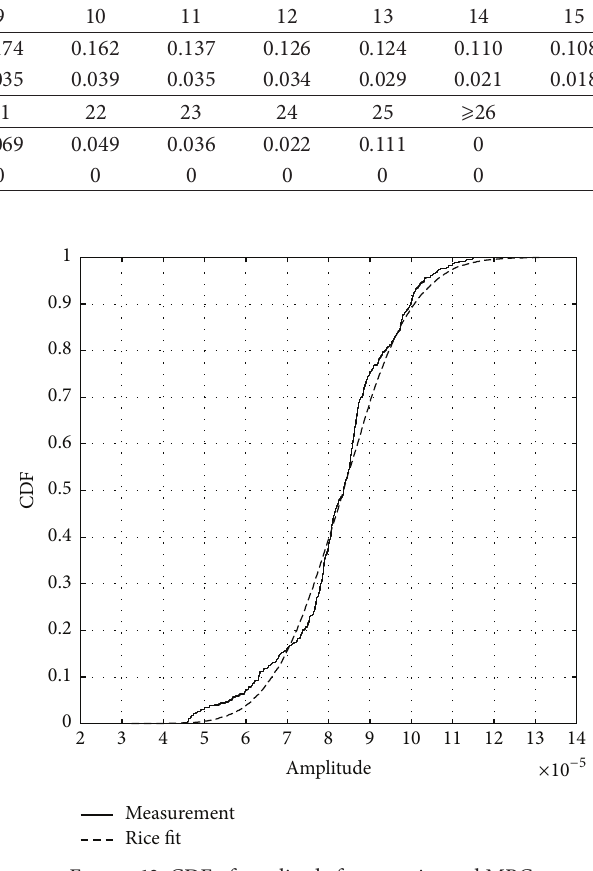
Figure 13: CDF of amplitude for an estimated